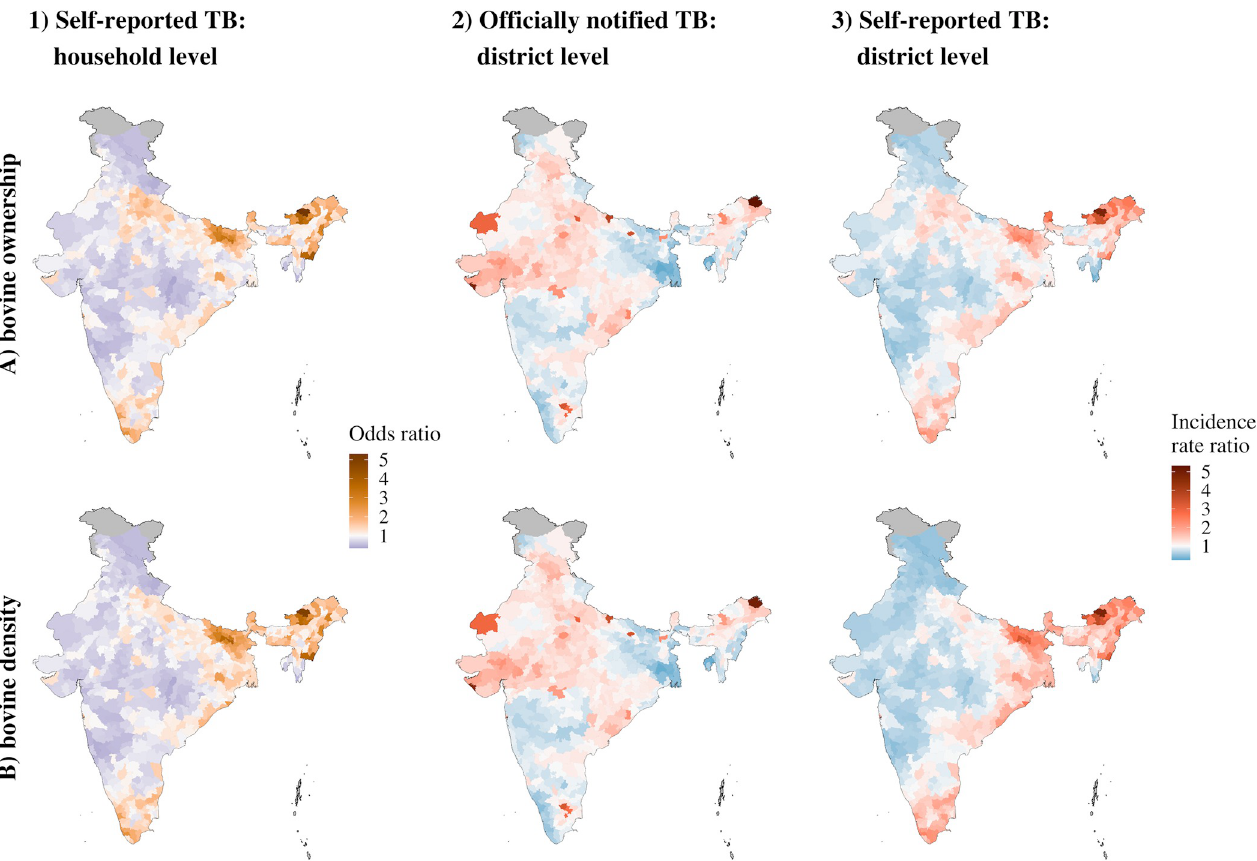
Fig 4. Estimated unexplained spatial variation in 1) self-reported tuberculosis in households, 2) officially notified tuberculosis at district level, and 3) self- reported tuberculosis in households at district level in India compared to the overall risk of tuberculosis reporting in the country after accounting for bovine ownership in households (A) or cattle and buffalo density (B) and cofounding variables. OR = odds ratio, IRR = incidence rate